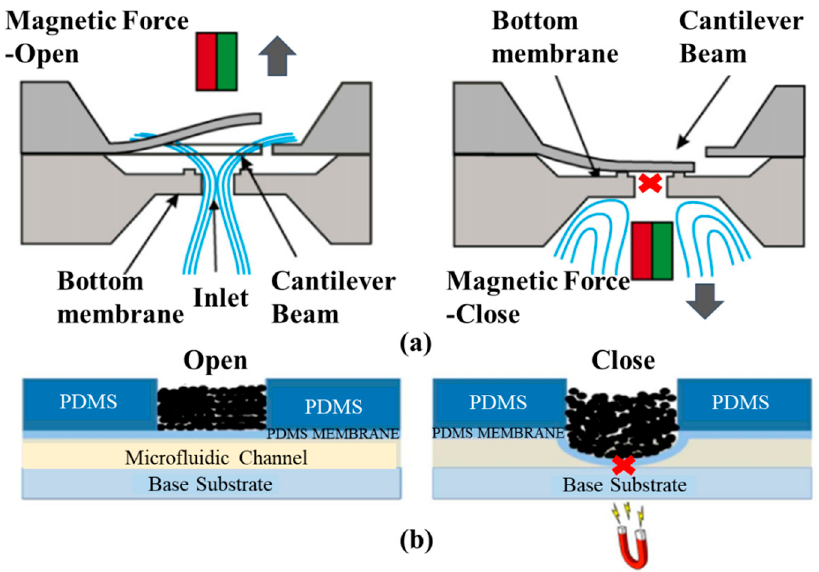
Figure 7. Schematics of two magnetic microvalves: ( a ) an externally magnetic ON / OFF microvalve [57]; ( b ) a magnetic microvalve based on MR fluid [58].